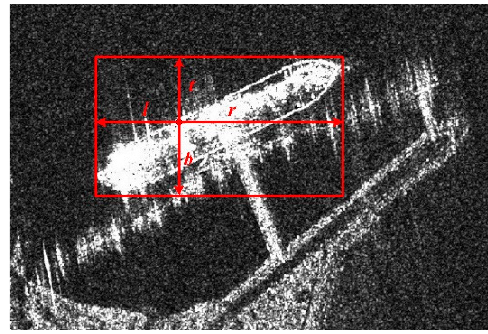
Figure 3. The architecture of FCOS. C denotes the number of classes. 2.2. Sample Definition Redesign SAR images and natural images have obvious differences in imaging conditions and object categories. Therefore, the previous sample definition methods based on the inter- section over union (IoU) threshold, or the scale range will not be suitable for SAR ship detection. Therefore, we introduced a new sample definition method, which defines the sample threshold according to the statistical characteristics of SAR ships. The specific pro- cess is as follows: Step 1 : For a ground-truth box